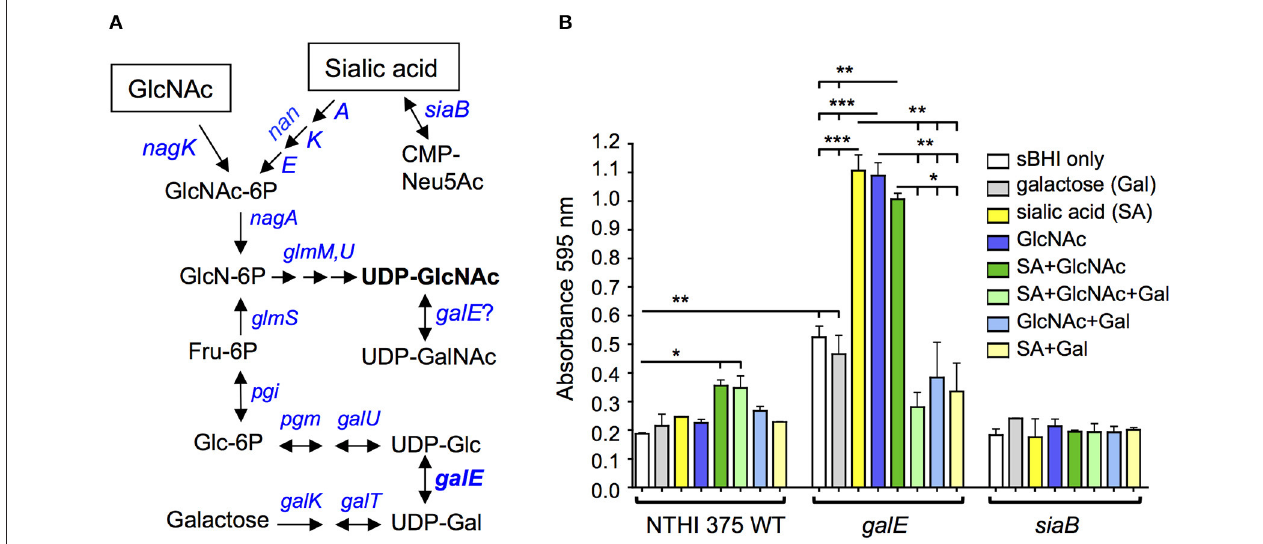
FIGURE 13 | Exogenous UDP-GlcNAc precursors fuel biofilm production. (A) Amino sugar and nucleotide sugar metabolic pathway for generation of UDP-GlcNAc in H. influenzae (adapted from KEGG (Kyoto Encyclopedia of Genes and Genomes) pathway database (https://www.genome.jp/kegg/pathway.html). (B) NTHi 375 wild-type (WT) with isogenic mutants galE and siaB were grown in sBHI for 24 hr in the presence of galactose, sialic acid, N -acetylglucosamine (GlcNAc) or combinations of the three in microtiter plates and biofilm formation was quantified by crystal violet staining. Log-transformed values were evaluated by one-way ANOVA with Bonferroni’s multiple comparison test (* p < 0.05; ** p < 0.01; *** p < 0.001). GlcNAc-6P, N -acetylglucosamine 6-phosphate; GlcN-6P, D-glucosamine 6-phosphate; UDP-GlcNAc, UDP- N -acetylglucosamine; UDP-GalNAc, UDP- N -acetylgalactosamine; Fru-6P, β -D-fructose 6-phosphate; Glc-6P, α -D-glucose 6-phosphate; CMP-Neu5Ac, cytidine monophosphate sialic acid; UDP-Glc, UDP-glucose; UDP-Gal, UDP-galactose; UDP, uridine